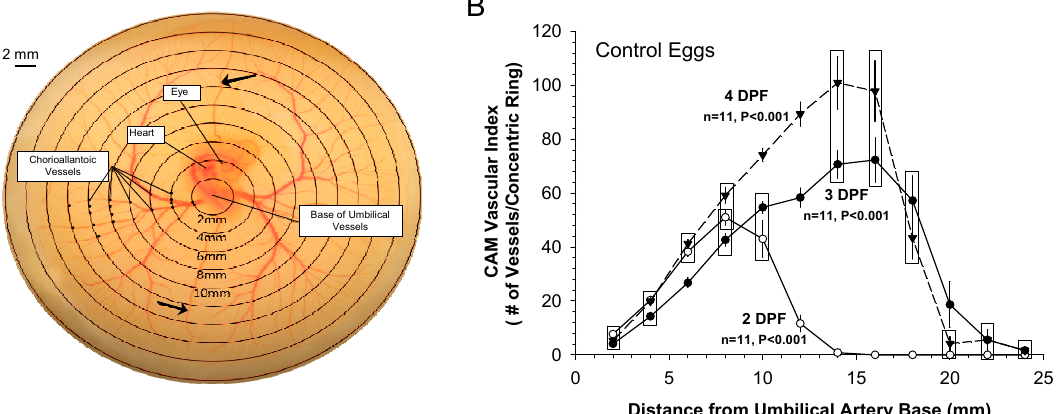
Figure 4. Vascular index of the CAM. ( A ) A commonly employed methodology for determining a vascular index for the chorioallantoic membrane of the chicken embryo grown ex ovo involves digital analysis of images of the living CAM. Variations on this methodology have been long established for both chicken and alligator embryos [40,92,93]. Embryos are first grown ex ovo on yolk in glass dishes, which provides for normal development of the circulation superficially on the yolk [4,94], allowing for easy observation of the vasculature. This photo of the CAM of a 3-day-old embryo was digitally superimposed upon its concentric rings centered on the base of the umbilical artery, and extending out every 2 mm past the edge of the growing CAM. The vascular index is calculated from the number of visible blood vessels (not discriminating between arterial or venous vessels) that intersect any point on each concentric ring. No distinction is made between arteries and veins in this analysis, as the two vessels are usually visually indistinguishable without surgical intervention at this early stage of development. ( B ) Developmental changes in in vivo vascularization in the chicken embryos from Day 2 to Day 4 is revealed by a plot of vascular index as a function of distance from the embryo. Mean values ± SE are shown. n = 11 for each point for each day. Arrows indicate superior and inferior vessels subjected to additional quantification in Figure 4B,